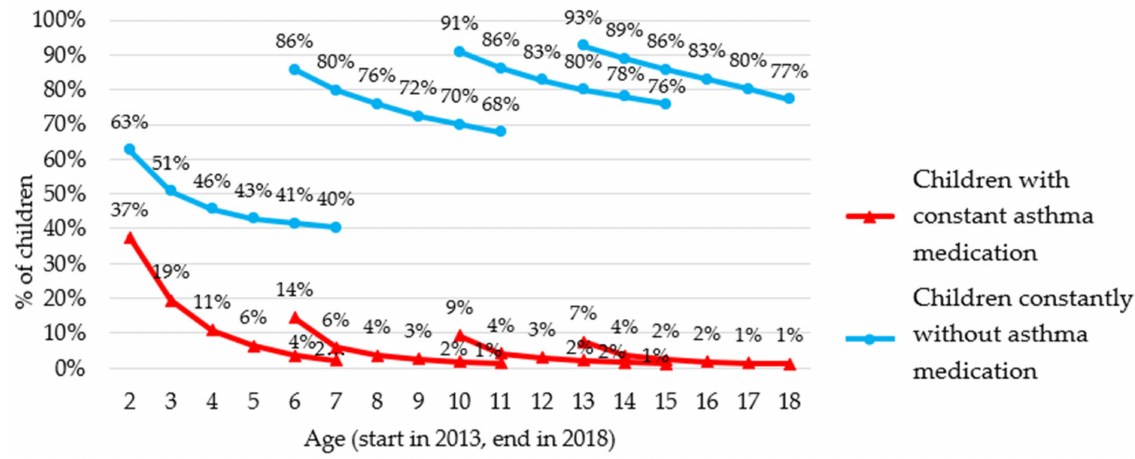
Figure 3. Follow-up between 2013 and 2018 of children aged 2, 6, 10, and 13 years who were not taking asthma medication or were taking at least one in 2013.